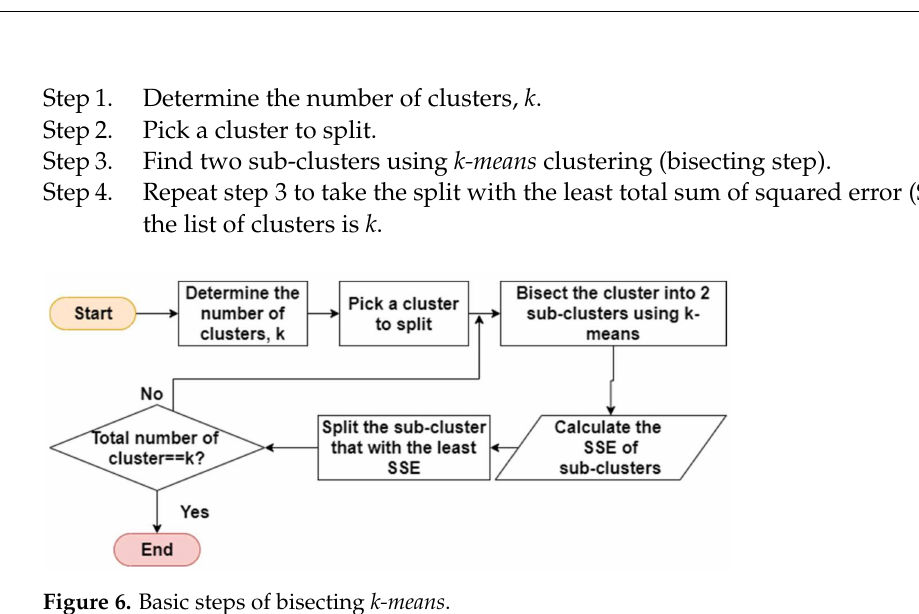
Figure 6. Basic steps of bisecting k-means .